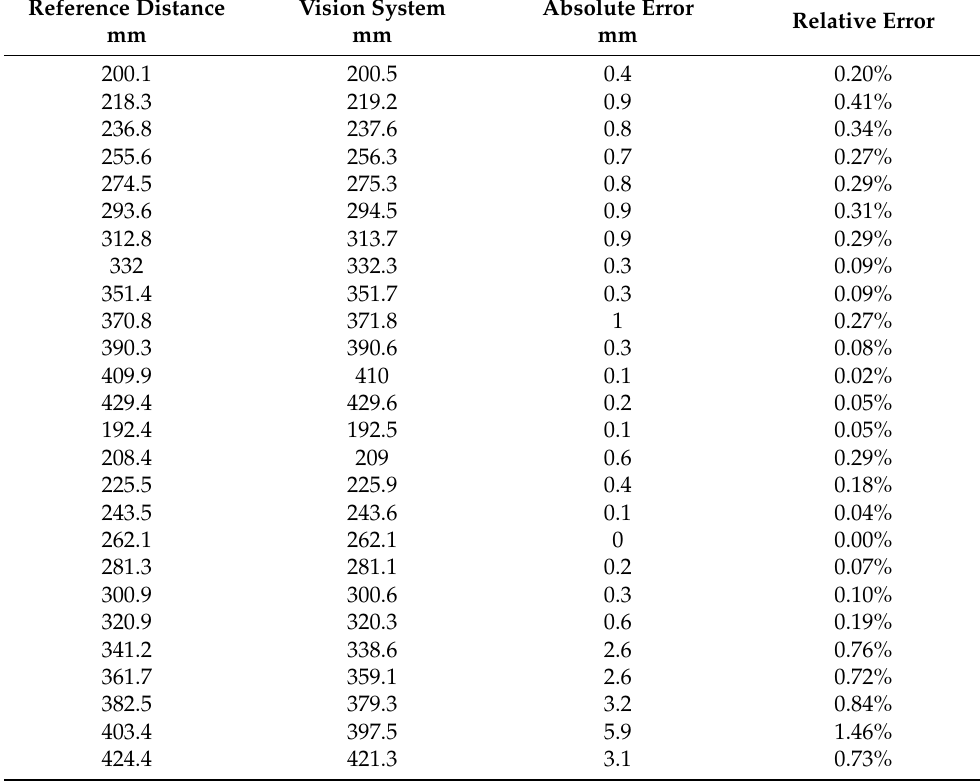
Table 2. Distance measurements by a vision